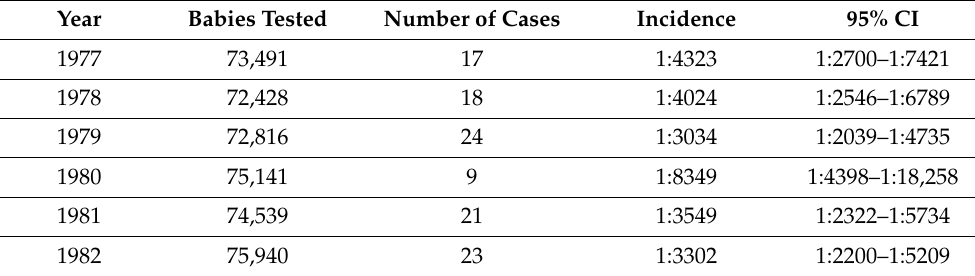
Table 2. Incidence of CH in Switzerland from 1977 – 2021.